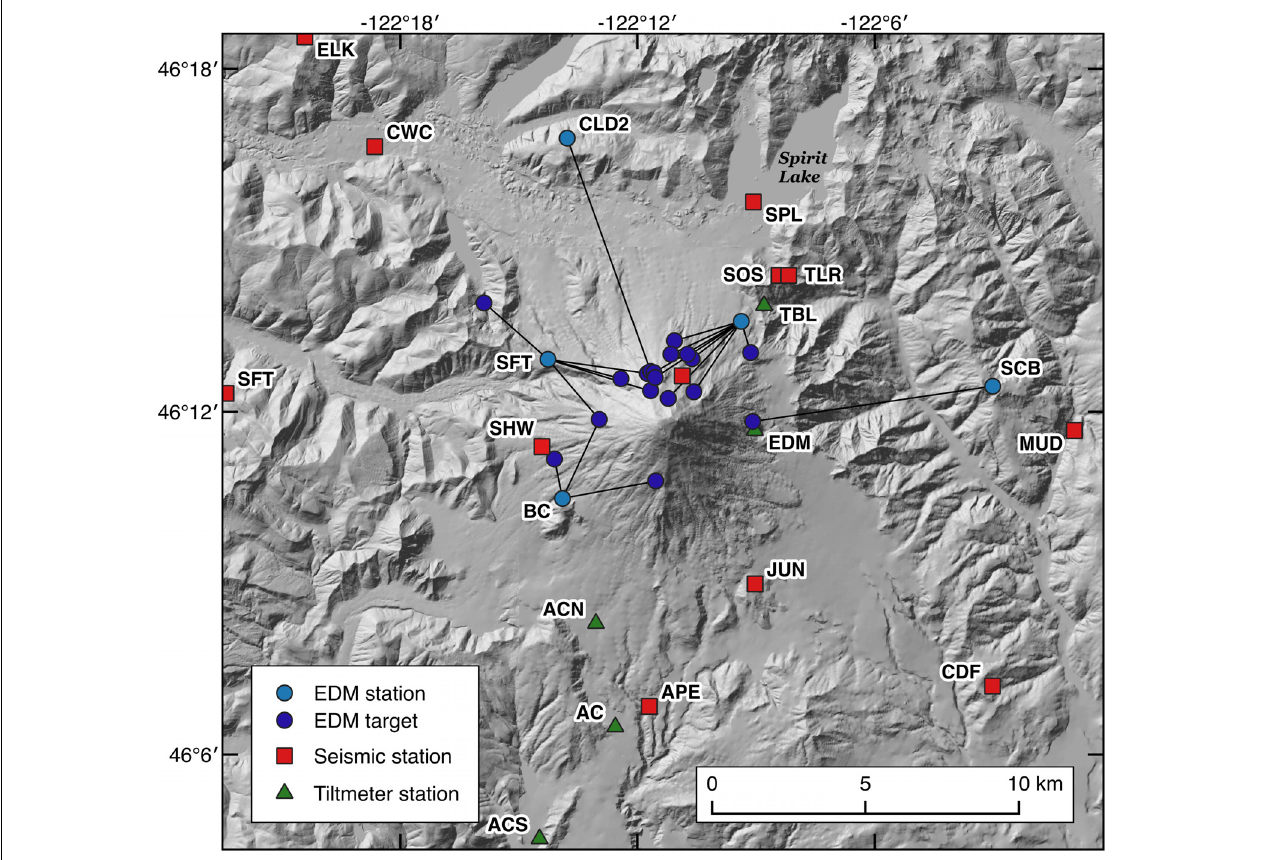
FIGURE 1 | Map showing seismic, EDM, and tiltmeter stations at Mount St. Helens prior to the 1980–1986 eruption. Seismic station SHW and EDM line EDM–SCB were installed or first measured in 1972, respectively; all other stations and lines were installed or first measured after the onset of intense shallow seismicity on March 20, 1980. In addition to the spirit-level triangle at Timberline campground (TBL), the surface of Spirit Lake was used as a water tiltmeter (see text). Some peripheral seismic stations are omitted to keep the map at a legible scale. Seismic station locations are from Malone et al. (1981). EDM station and target locations are from Lipman et al. (1981). Tiltmeter station locations are from Dvorak et al. (1981). See original publications for additional information. Hillshade is based on a USGS topographic map and depicts pre-1980